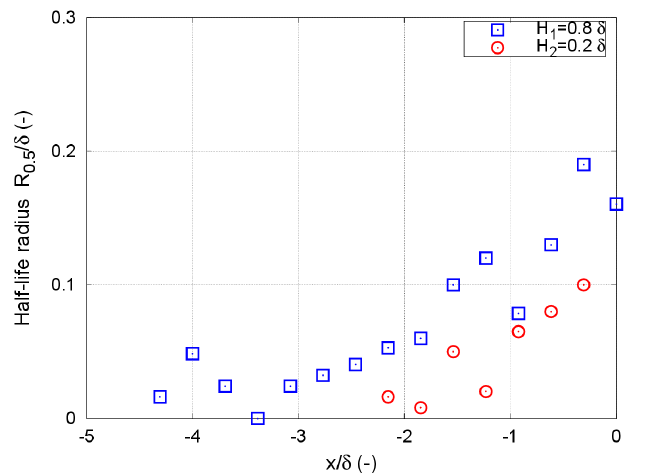
Figure 13. Vortex size evolution expressed in terms of the normalized half-life radius R 0.5 at difference normalized distances x / δ for the H 1 = 0.8 δ (blue rectangles) and H 2 = 0.2 δ (red circles) vane-type VG